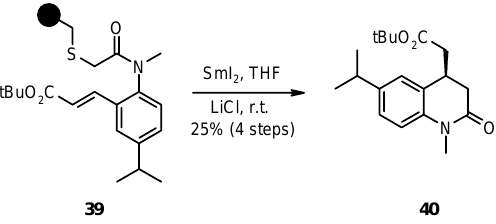
-mediated cyclative 2